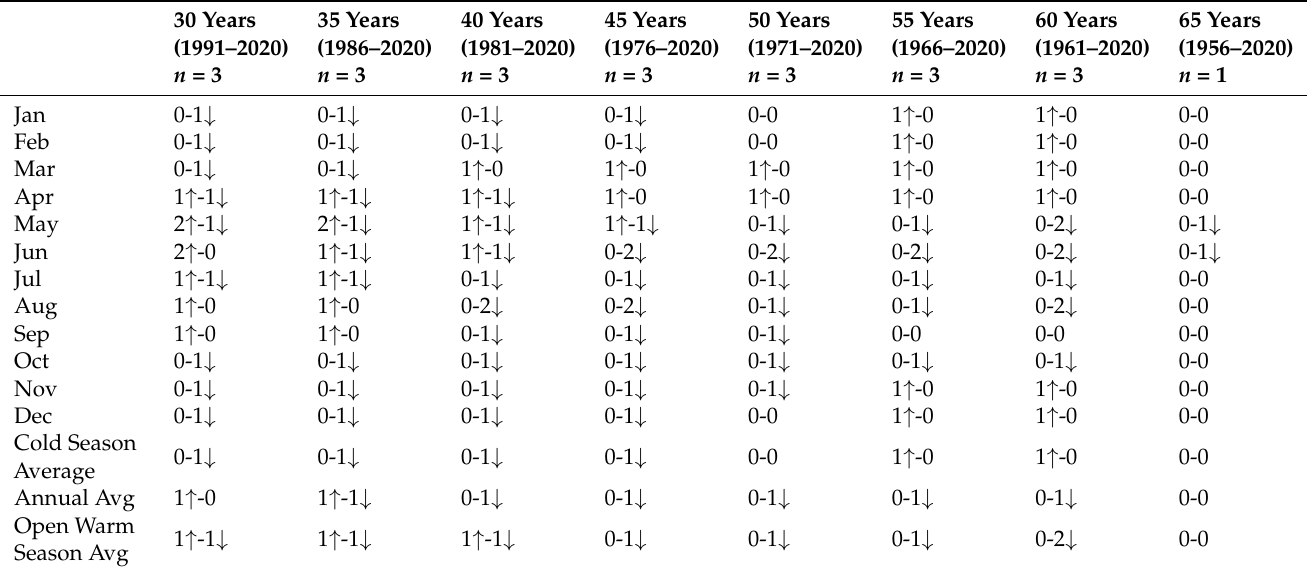
Table 5. Number of gauging stations with a significant increasing ( ↑ ) or decreasing ( ↓ ) water flow trend ( ≥ 90% significance) along the Peace